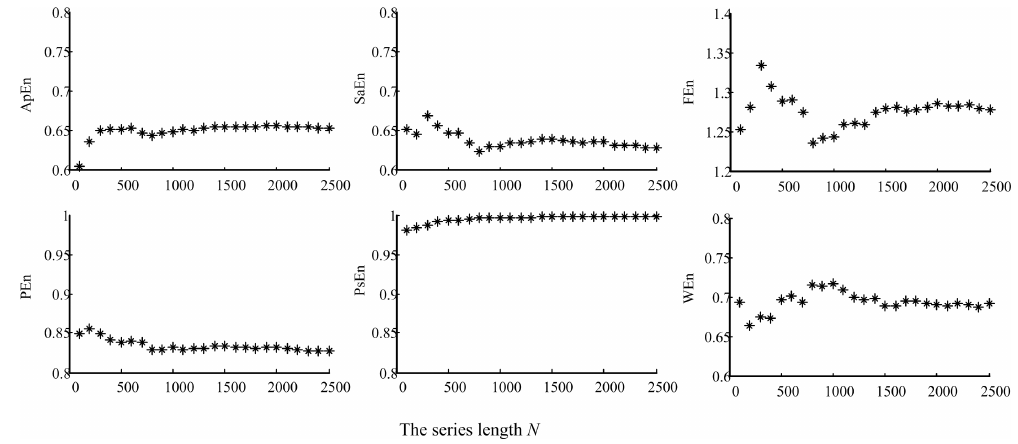
Fig. 3. The in°uence of di®erent series length on ApEn, SaEn, FEn, PEn, PsEn and WEn